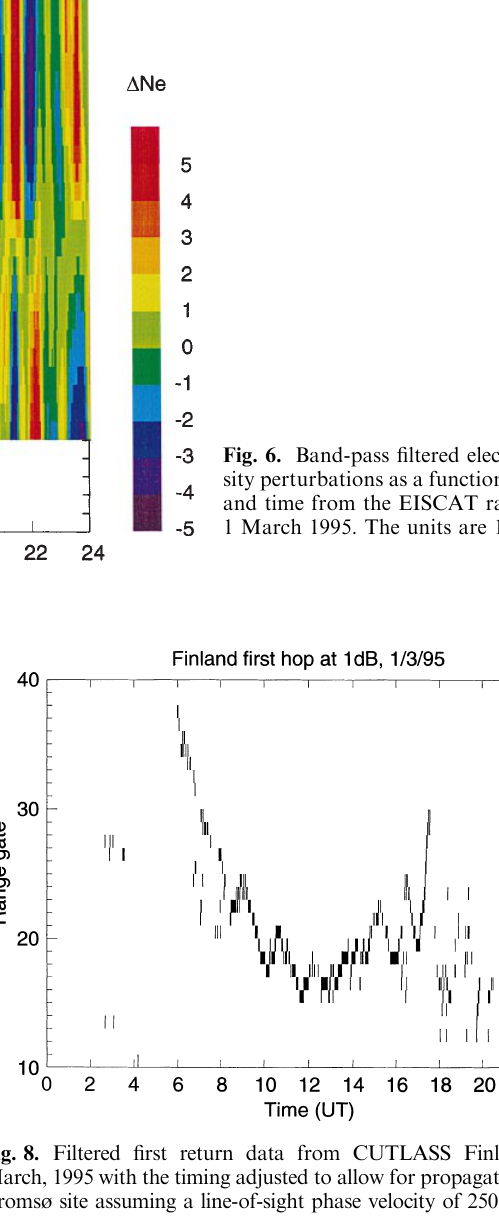
Fig. 7. Band-pass filtered electron density perturbations at a height of 250 km for 1 March, 1995